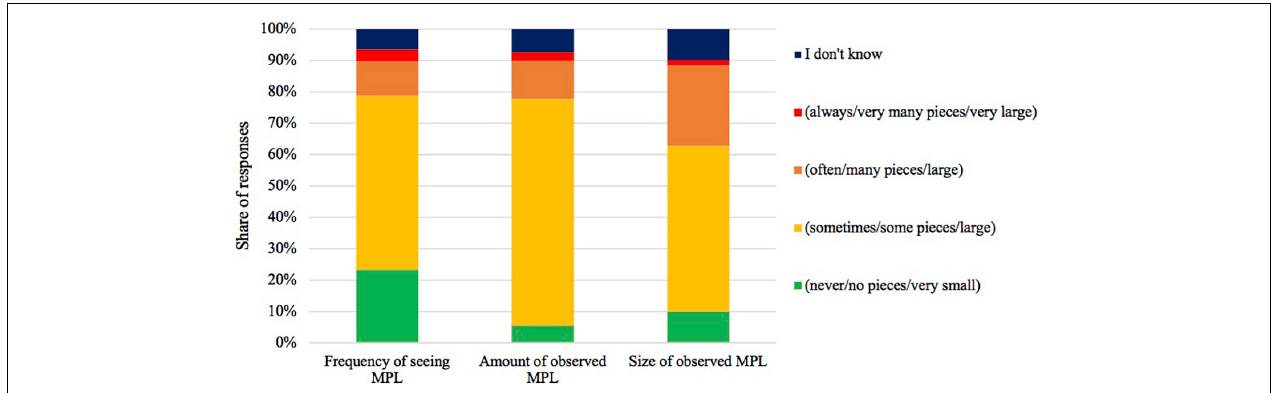
FIGURE 1 | Distribution of beach or coastal visitors’ experiences with MPL. Explanatory note: the shares refer to the replies to the following three questions: Frequency: “ How often did you see plastic litter on the beach or in the water? ” Amount: “ How would you describe the amount of plastic litter on the beach or in the water? ” Size: “ How would you describe the size of the most noticeable plastics on the beach or in the water? ”